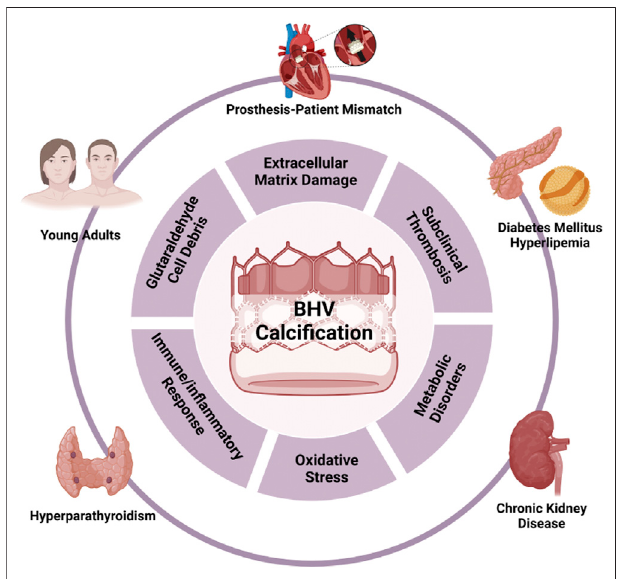
FIGURE 3 | Risk factors and mechanisms of BHV calci fi